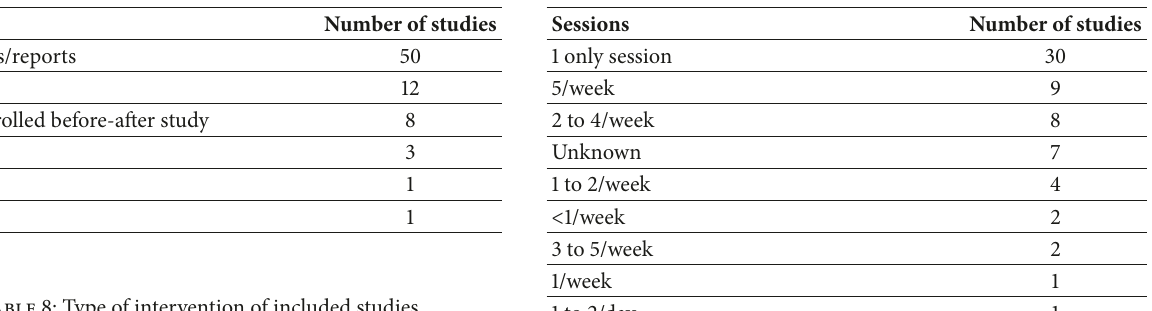
Table 7: Design of included studies.